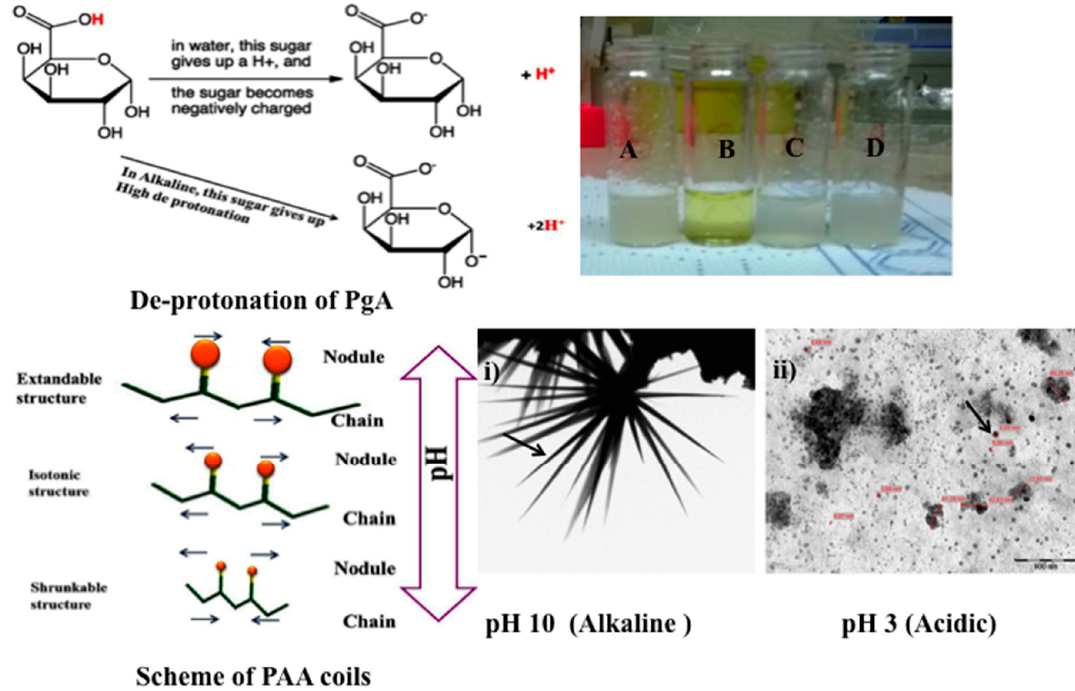
Figure 1. ( Left ) scheme of polygalacturonic acid (PgA) de-protonation and scheme of poly (acrylic) acid (PAA) coils; ( Right ): PgA at different pH; (A) Distilled water; (B) pH 10; (C) pH 7.2; (D) pH 3. TEM images of (i) PAA at alkaline pH and (ii) PAA at acidic pH. (Arrows indicate different nanoparticles shape).